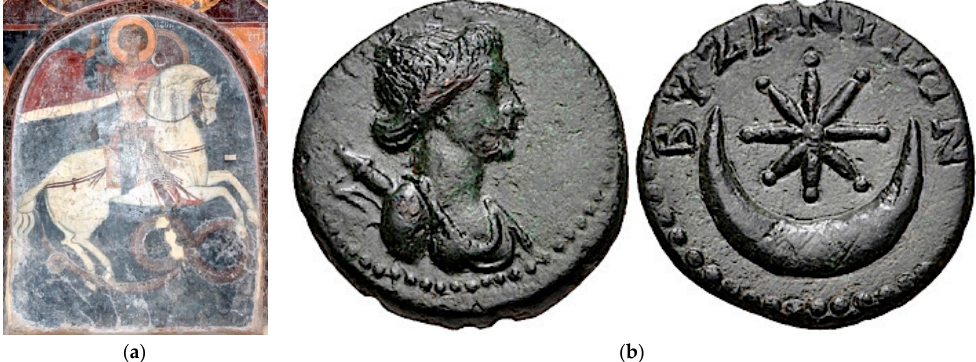
Figure 5. ( a ) St George. Hagios Ioannis Chrysostomos at Geraki, c. 1300. © Used with permission of the